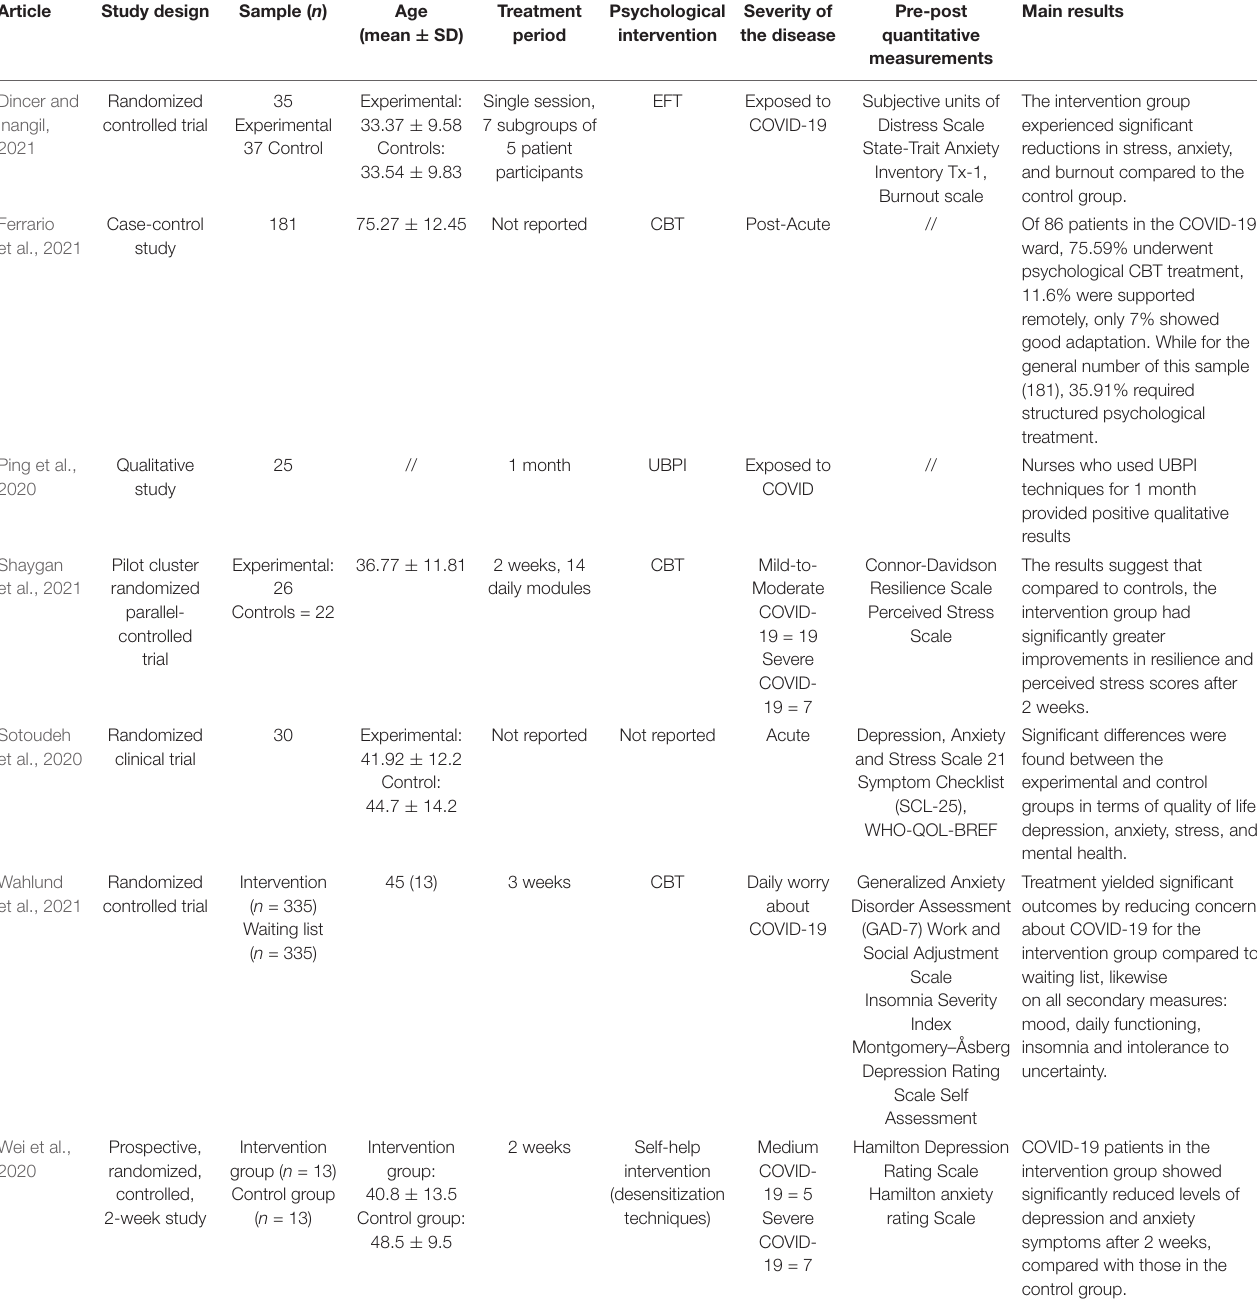
TABLE 1 | Psychological interventions delivered to COVID-19